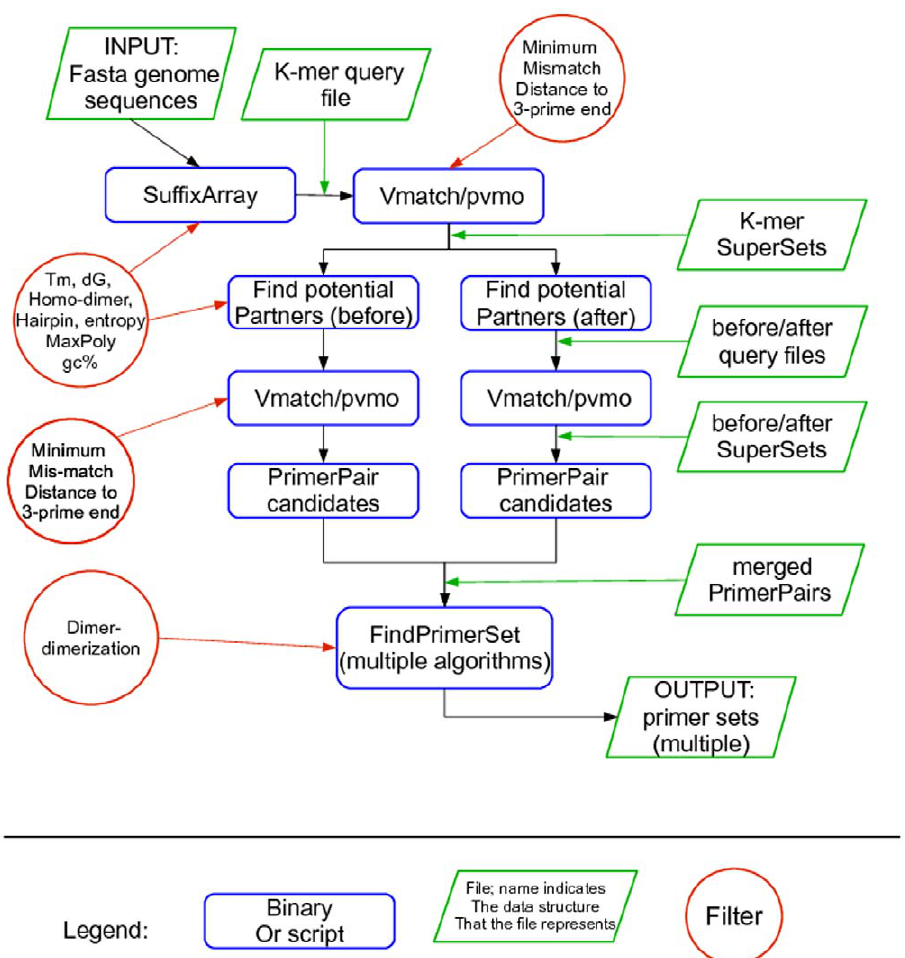
Figure 3. Diagram of the PriMux software workflow.